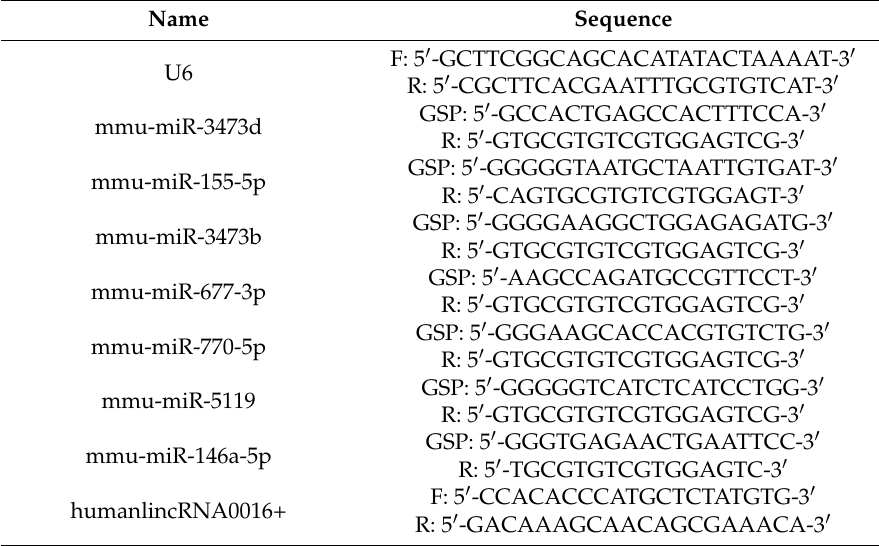
Table 1. PCR primers used in this